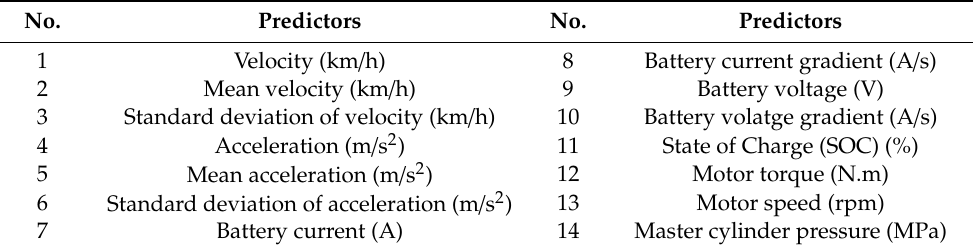
Table 1. Predictors’ used for model